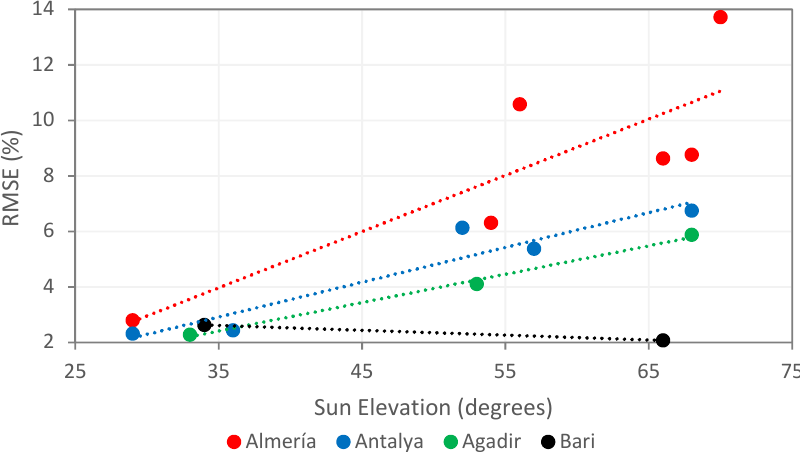
Figure 11. The relationship between the sun elevation and the coherence of S2 L2A vs. L8 PANSH measured as RMSE (all the six bands) for each date and study site.